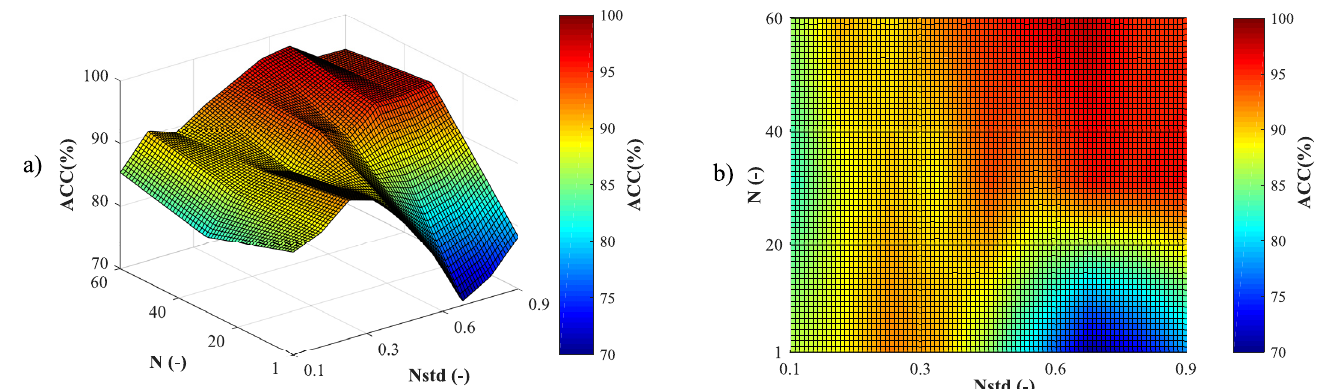
Fig 20. Illustration of the influence of parameter settings ( N and N of the 3D graph and b) the top-down view.